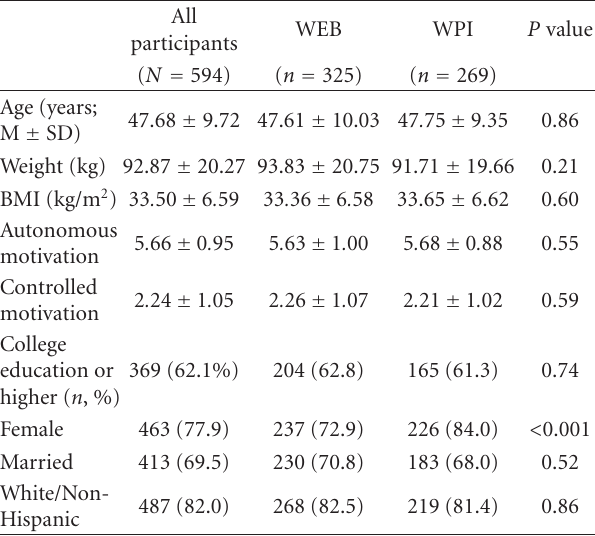
Table 1: Baseline demographic